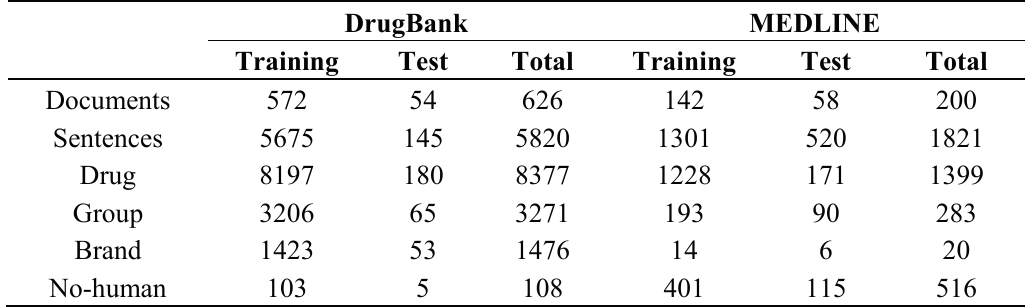
Table 1. Statistics of the drug-drug interaction extraction (DDIExtraction) 2013 corpus.